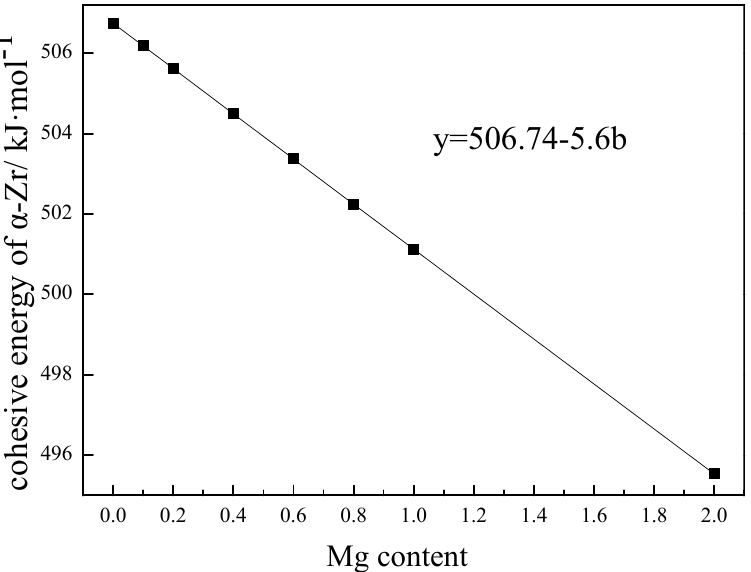
Figure 3. Cohesive energy of Zr with different Mg contents.